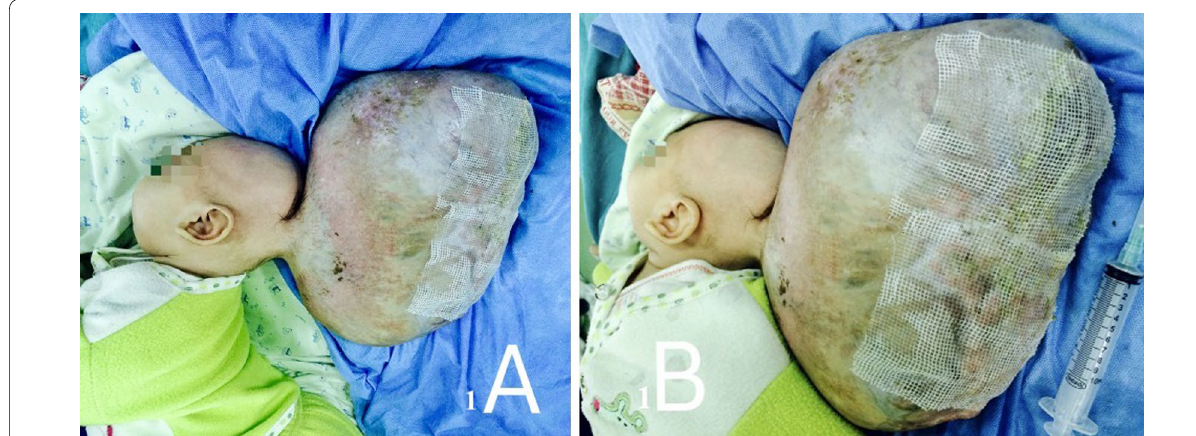
Fig. 1 A Giant occipital encephalocele. B Giant occipital encephalocele (21